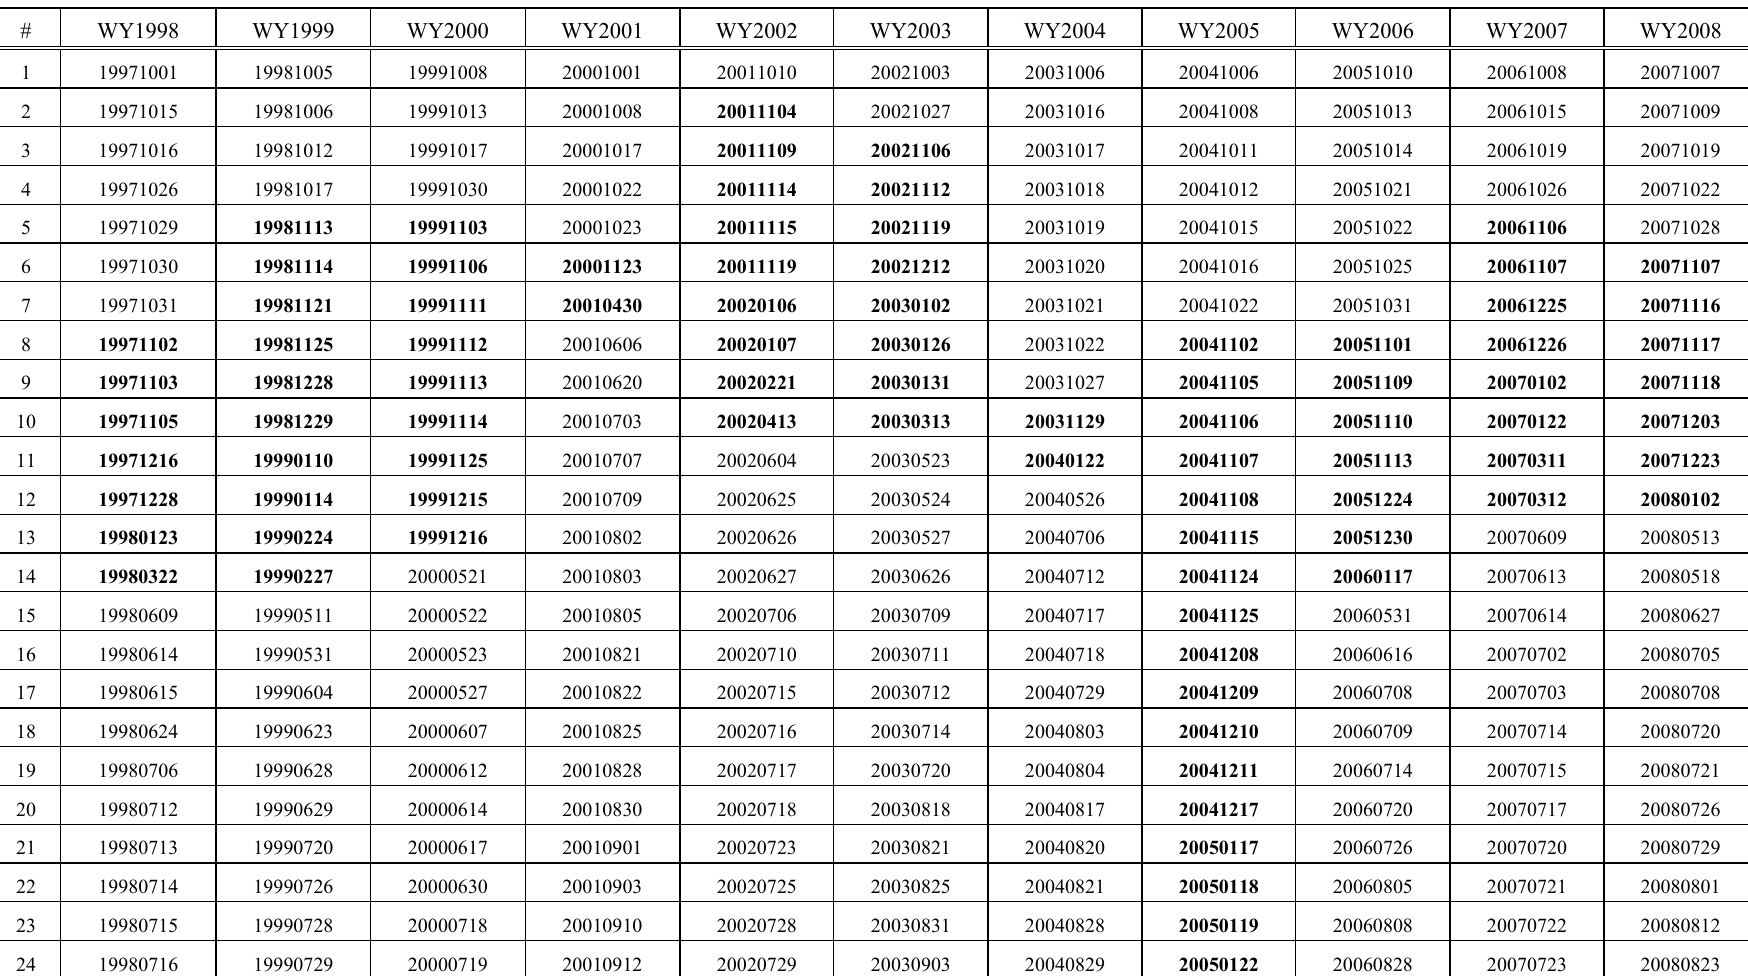
Table 1b. Dates of SSM/I observations of landfalling atmospheric rivers (ARs; long, narrow plumes of integrated water vapor with core values >~2 cm) during the water years 1998–2008 that impacted the Oregon/Washington/British Columbia coast (41.0° N–52.5° N) on both the morning ascending SSM/I passes and the afternoon descending passes. The AR events in the November-April window considered in this paper are